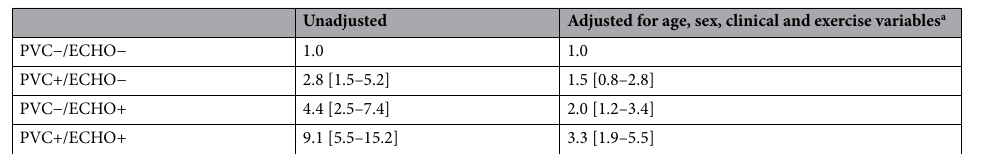
Table 3. Hazard ratios [95% CI] for cardiovascular mortality based on combination of absence/presence of PVCs during recovery, and presence or absence of significant echocardiographic abnormalities, n = 3,106 (219 events). ECHO− no significant abnormality on echocardiography, ECHO+ significant abnormality on echocardiography, PVC premature ventricular contractions, PVC− < 1 PVCs/min during recovery, PVC+ ≥ 1 PVCs/min during recovery. a Hypertension, diabetes, ischemic heart disease, heart failure, body-mass index, peak workload, maximal heart rate, heart rate recovery, maximal systolic blood pressure, ST depression, use of either betablocker, angiotension-converting enzyme inhibitor, angiotension II blockers, loop diuretics, antihrombotics, anti-coagulants, or calcium channel blockers. Coefficients of confounders are presented in Supplements Table C.